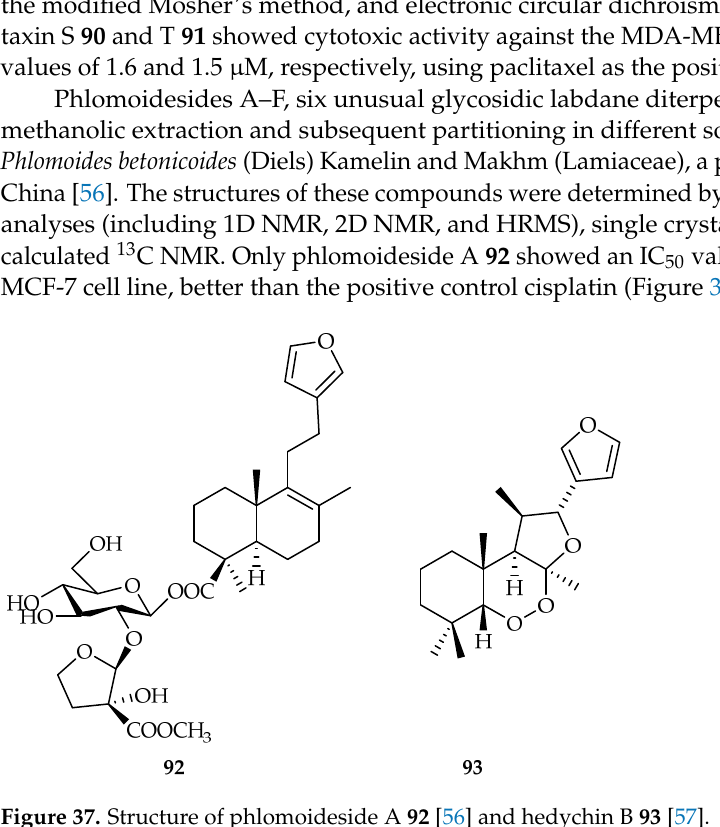
Figure 37. Structure of phlomoideside A 92 [56] and hedychin B 93 [57].